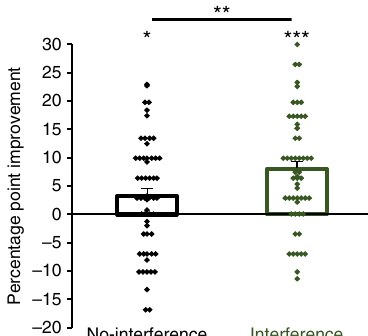
Fig. 7 Auditory classi fi cation performance improvement in